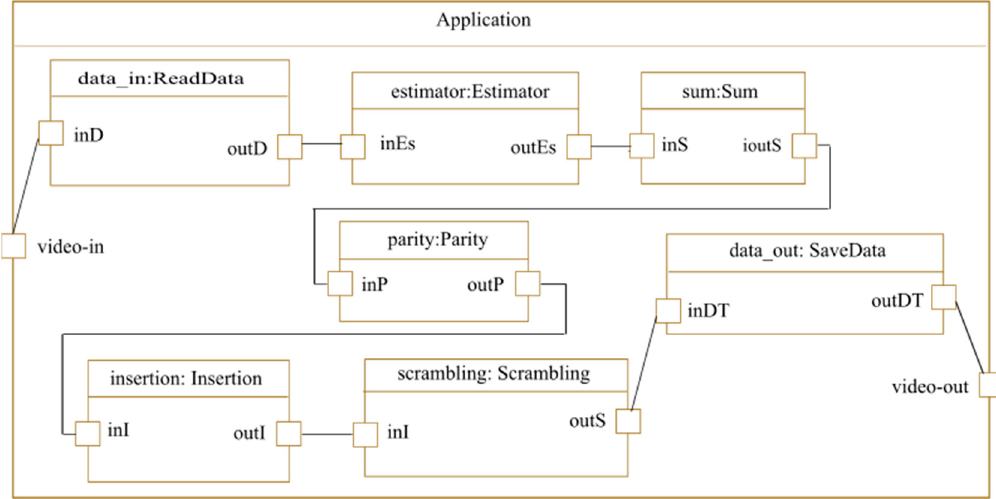
Figure 8. Application modeling.